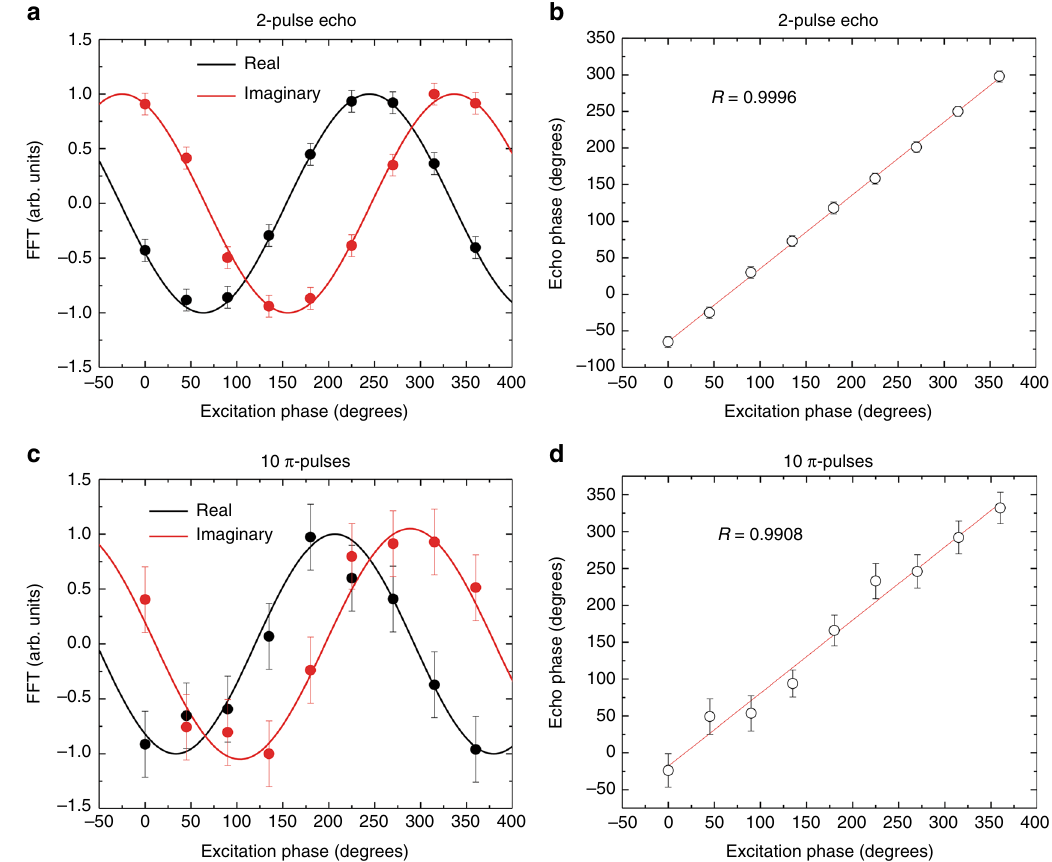
Fig. 4 Echo phase correlation. a , c Real and imaginary parts of the spin-echo signal FFT (circles) as a function of the excitation pulse phase for a two-pulse echo and a DD sequence ( τ = 300 µ s, τ DD = 150 µ s, n = 10). Solid lines: fi t with a sine function. Error bars were estimated from the signal to noise ratio in Supplementary Fig. 7 and Supplementary Fig. 8. b , d Echo pulse phase derived from FFT signals ( a , c ) as a function of the excitation pulse phase (see Methods). Lines: linear fi t; R correlation coef fi cient. Echo phase error bars were calculated by error propagation from the FFT signal to noise